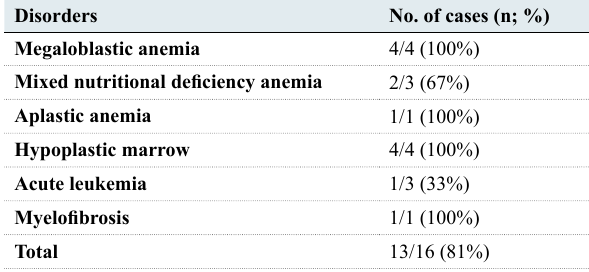
Table 2: Cases presenting as pancytopenia in various